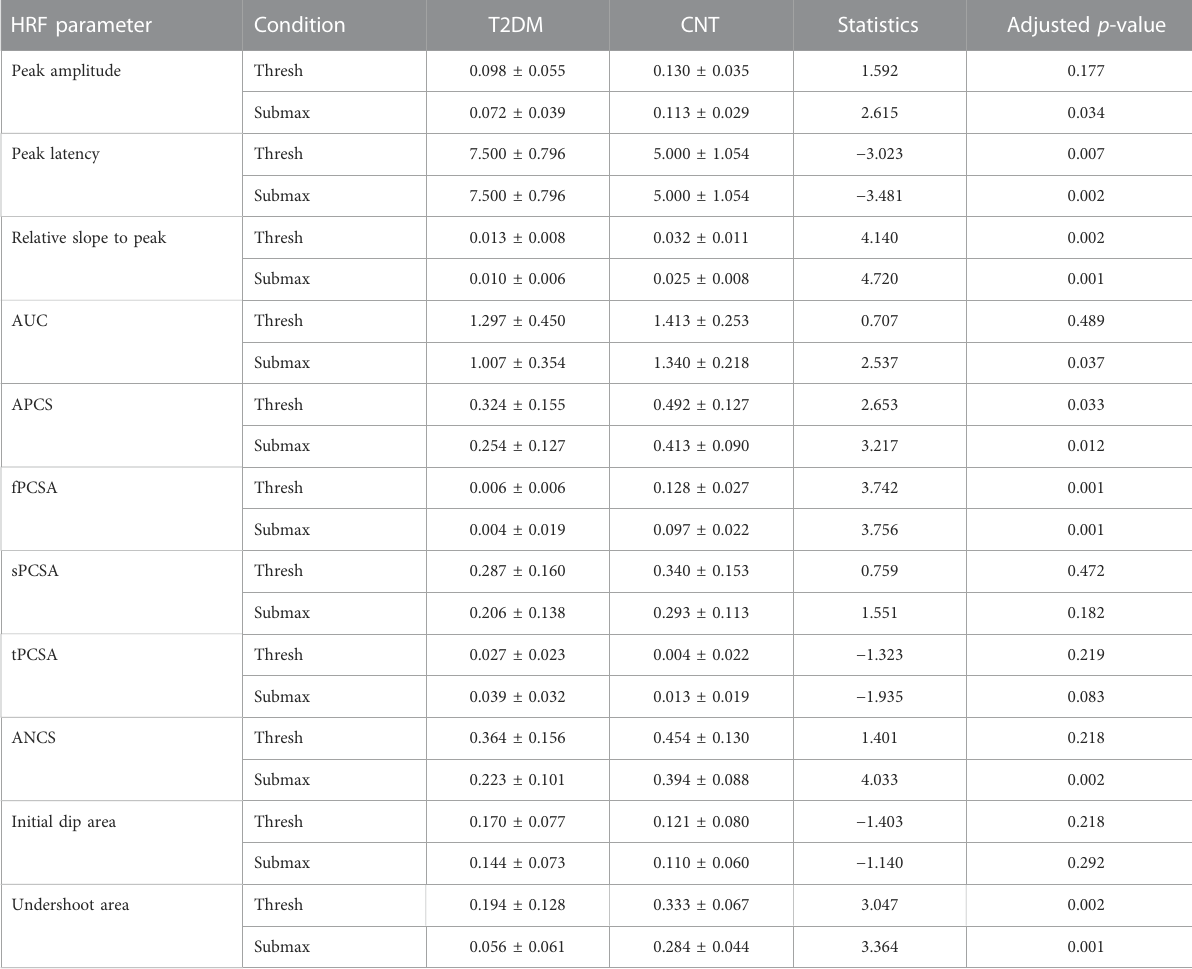
TABLE 4 Average (±SD) HRF parameters in ROIs with positive signal